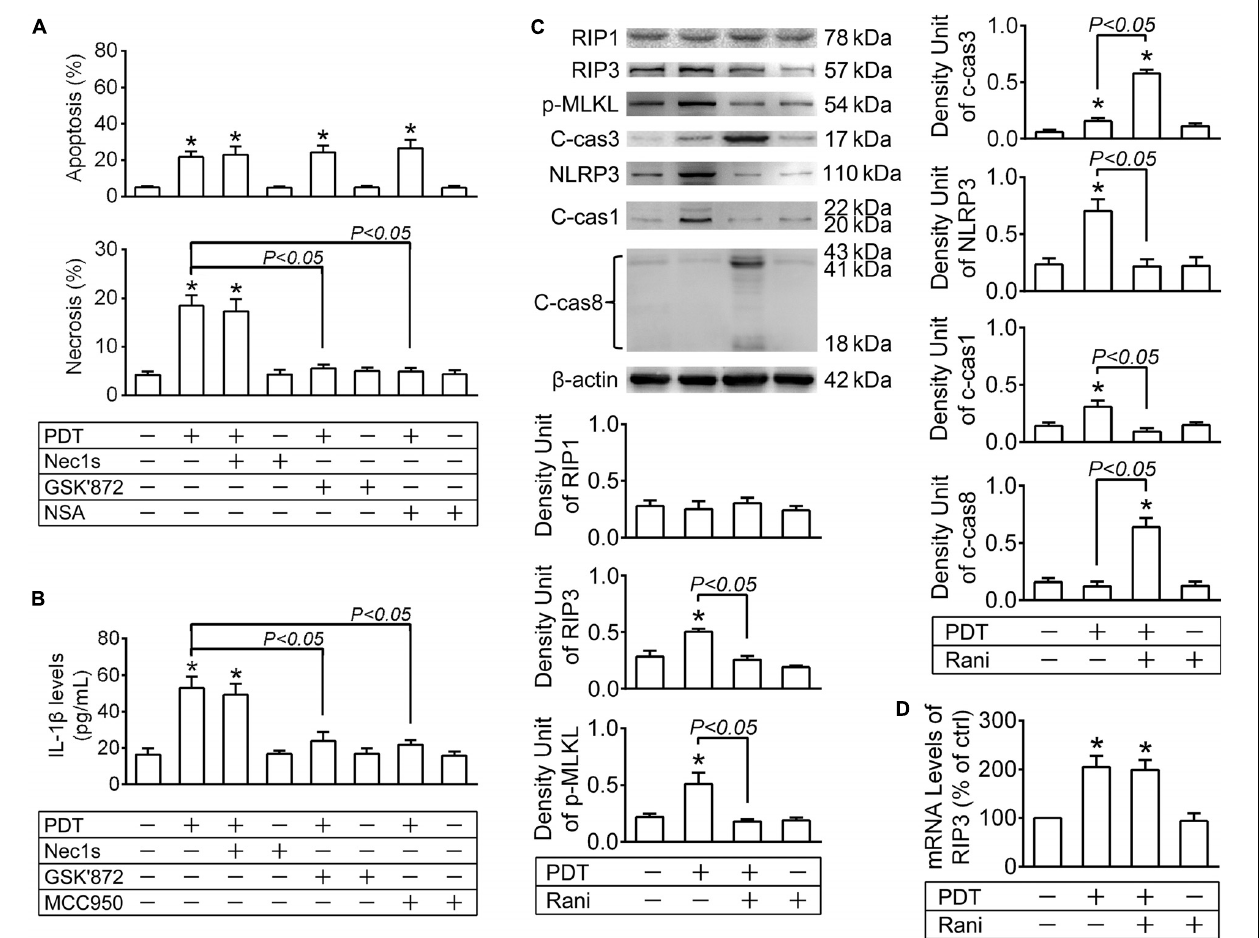
FIGURE 2 | The impacts of PDT and pre-treatment of rani on apoptotic, necroptotic and NLRP3 inflammatory pathways in RF/6A cells. RF/6A cells were exposed to PDT, rani was applied to the cells at 6 h before PDT, and Nec1s (a specific receptor interacting protein kinase (RIP) 1 inhibitor), GSK’872 (a selective RIP3 inhibitor), necrosulfonamide (NSA, a specific p-MLKL inhibitor) and MCC950 (a selective NLRP3 inhibitor) were administrated right after PDT. Various detections were performed at 12 h after PDT. (A) Cell apoptosis and necrosis were determined by flow cytometry. (B) IL-1 β protein levels in culture medium supernatants were measured via ELISA. (C) The protein levels of RIP1, RIP3, p-MLKL, c-cas3, NLRP3, c-cas1 and c-cas8 in RF/6A cells were detected by immnoblotting. (D) The mRNA levels of RIP3 were measured by real-time PCR analysis. n = 4; * P < 0.05, compared with the